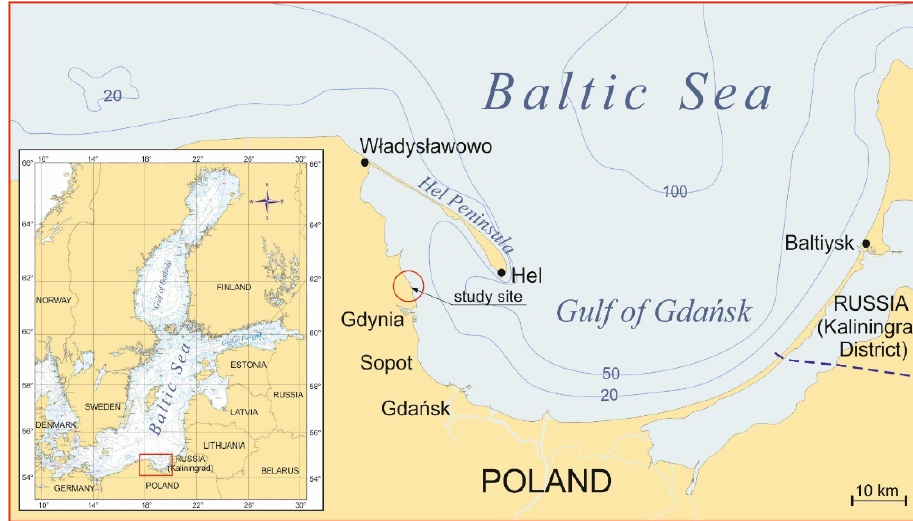
Figure 1. Location of the study site.